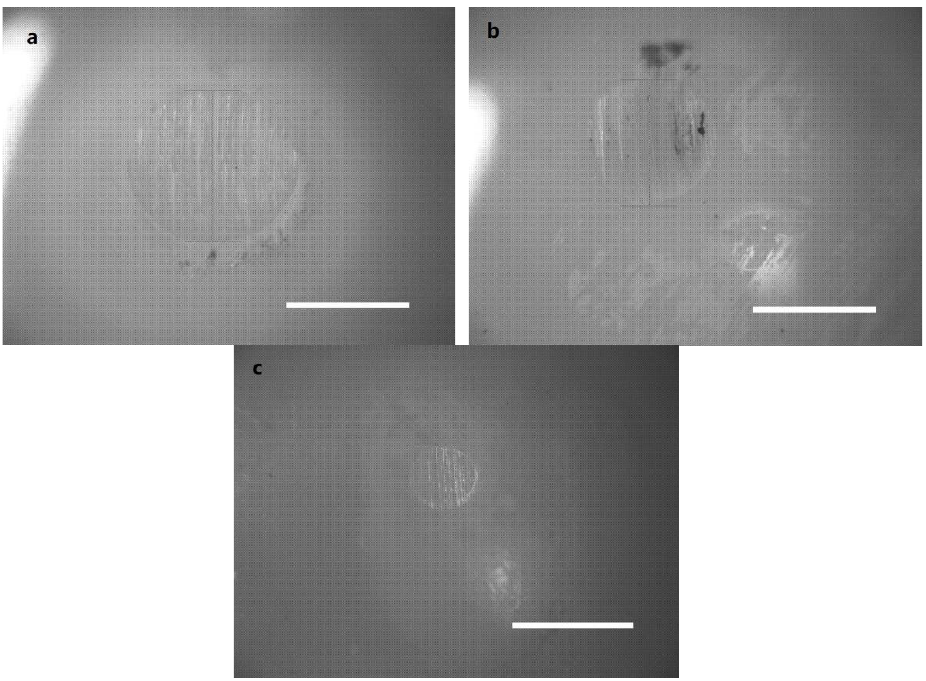
Figure 4. Images of the wear scar with HA ( a ); HA + BSA ( b ); HA + BSA-NPs ( c ). The concentration of HA was 15 mg/mL, and that of the additives was 15 mg/mL. The scale bar is 1 mm. The linear viscoelastic properties of HA solution and its mixtures are shown in Figure 5b. The angular frequency ( ω )-dependent elastic modulus (G (cid:48) ) and viscous